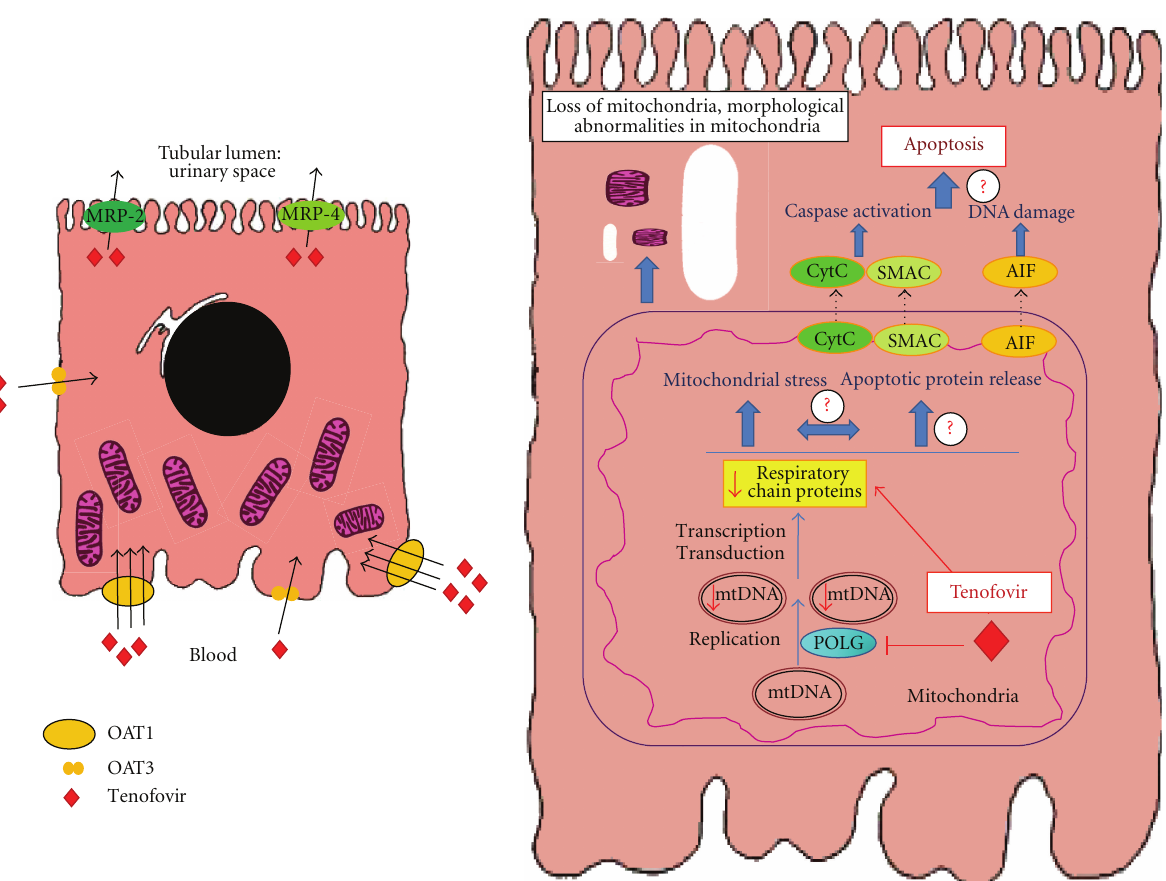
Figure 2: Tenofovir handling by proximal tubular cells and potential molecular mechanisms and clinical consequences of tenofovir nephrotoxicity. (a) Tenofovir secretion by proximal tubular cells: 20 to 30% of tenofovir is excreted unchanged in the urine